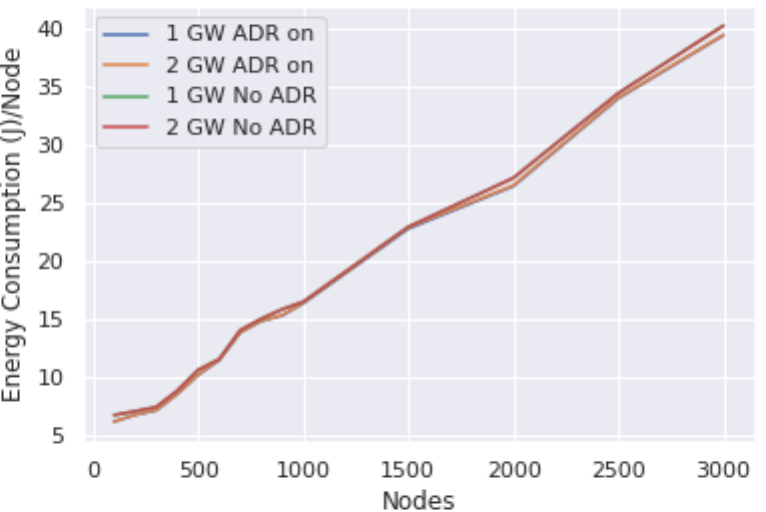
Figure 13. Average energy consumption per node with one and two gateways deployed, with and without Adaptive Data Rate (ADR).